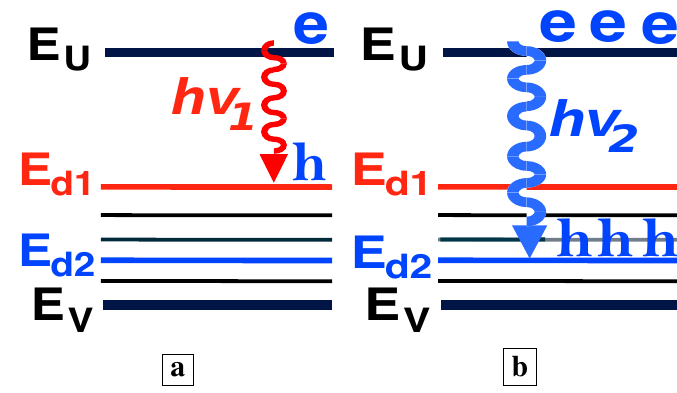
Figure 12 . Electron and hole population distributions which explain both the shift to shorter wavelengths of the stimulated-emission (the superlinear L-I) and the clamping of the long-wavelength emission in Figure 11 with increasing injection. a, At small injection, holes scatter up to midgap states. b, At higher injection, the large number of holes at energies (e.g., E ) further down from the midgap dramatically increases the shorter-wavelength (e.g., d2 hν ) optical-emission rate. Holes recombine radiatively (e.g., hν 2 can scatter up to midgap states. The optical-emission at hν long-wavelength